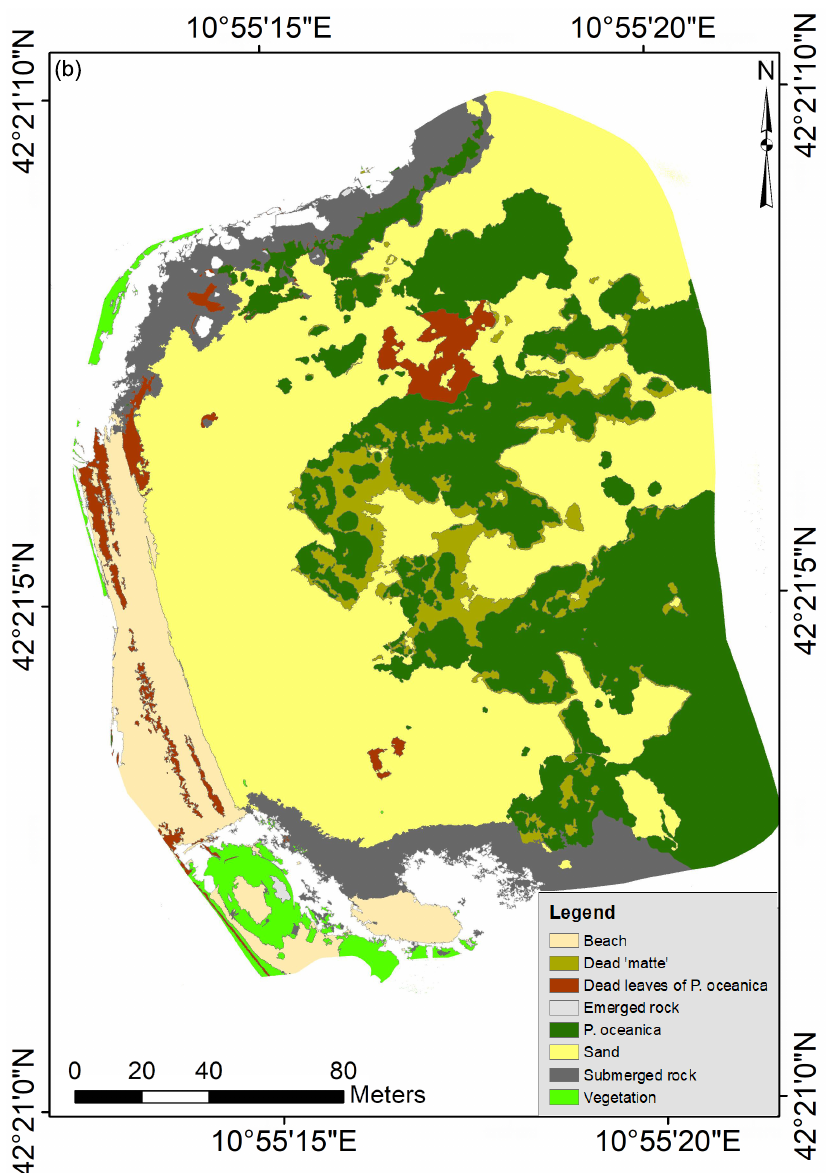
Figure 6. Segmentation results of the S1 site after OBIA methods ( a ) clearly demonstrate that the complex meadow area has been successfully segmented into different image objects and subsequently correctly classified into eight cover classes, producing a high-quality thematic map ( b